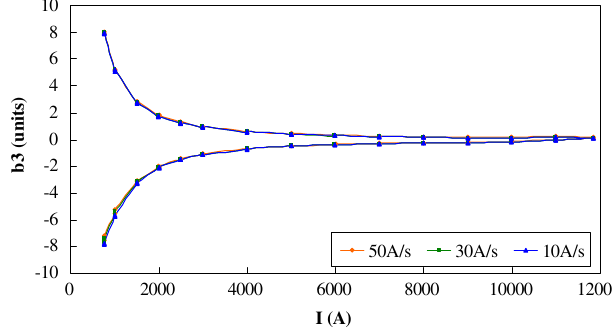
FIG. 8. (Color) Loadline measurement (MB2598 aperture 2) with different precycle ramp rates.